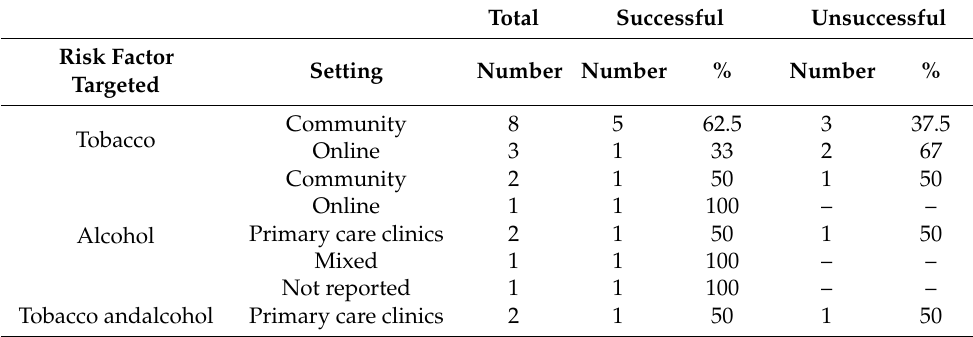
Table 2. Nudge intervention success rate based on the topic and